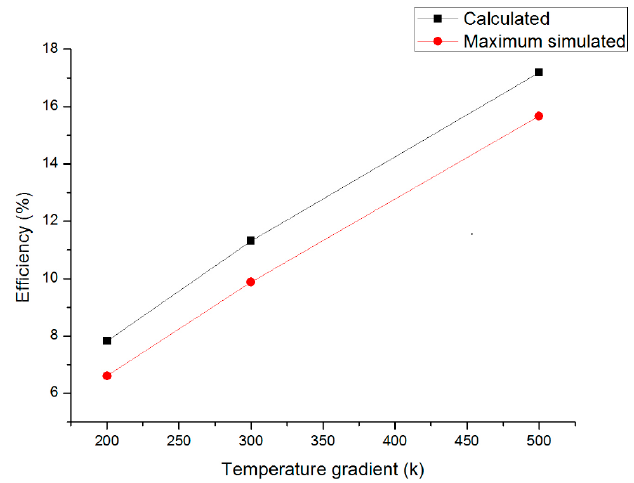
ffi ciencies for the segmented Figure 6. Comparison of the conversion efficiencies for the segmented TEG. Figure 6. Comparison of the conversion e Figure 6. Comparison of the conversion efficiencies for the segmented TEG.